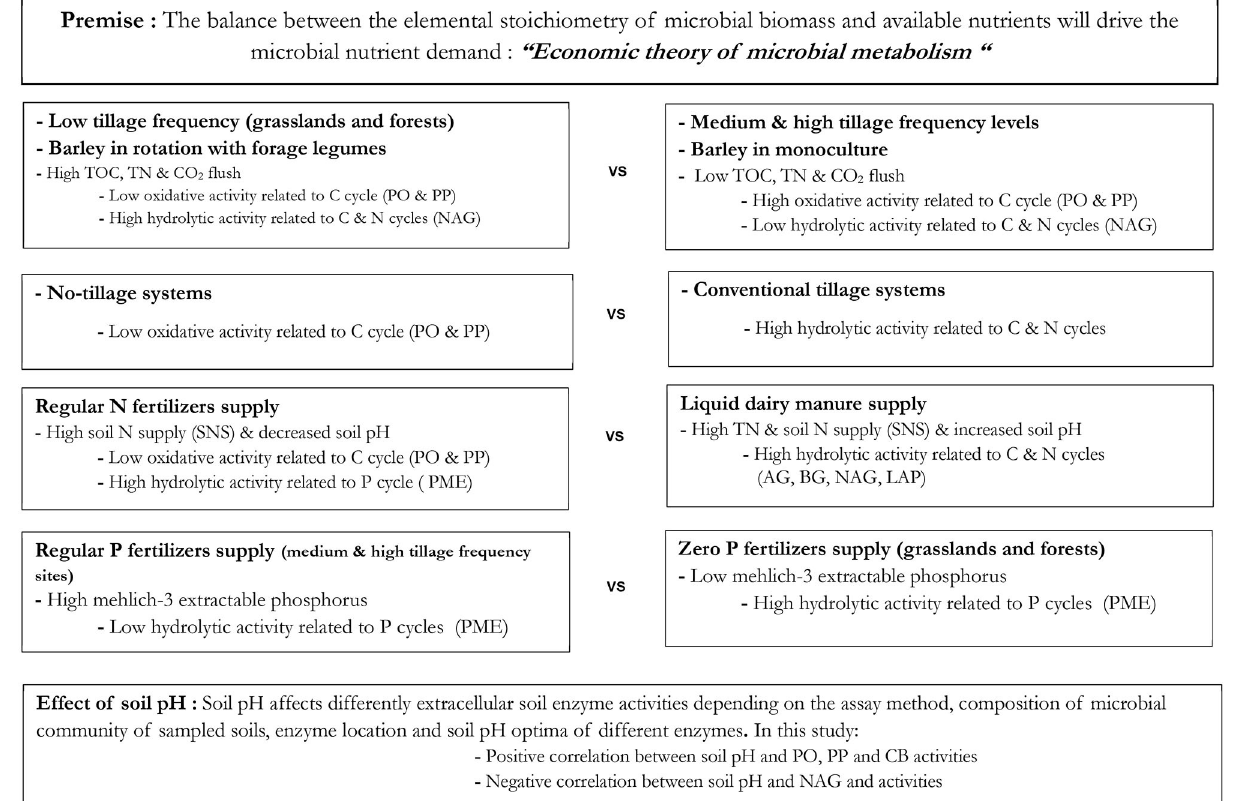
Frontiers in Soil Science |